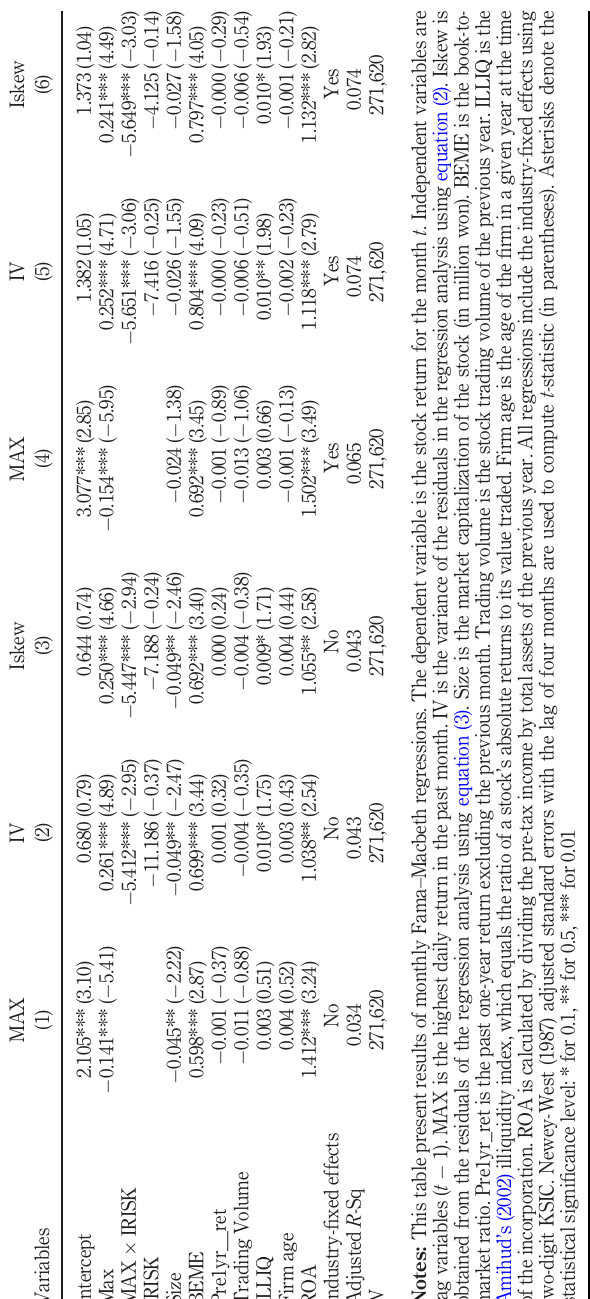
Table 3. Fama and MacBeth regressions: MAX and idiosyncratic